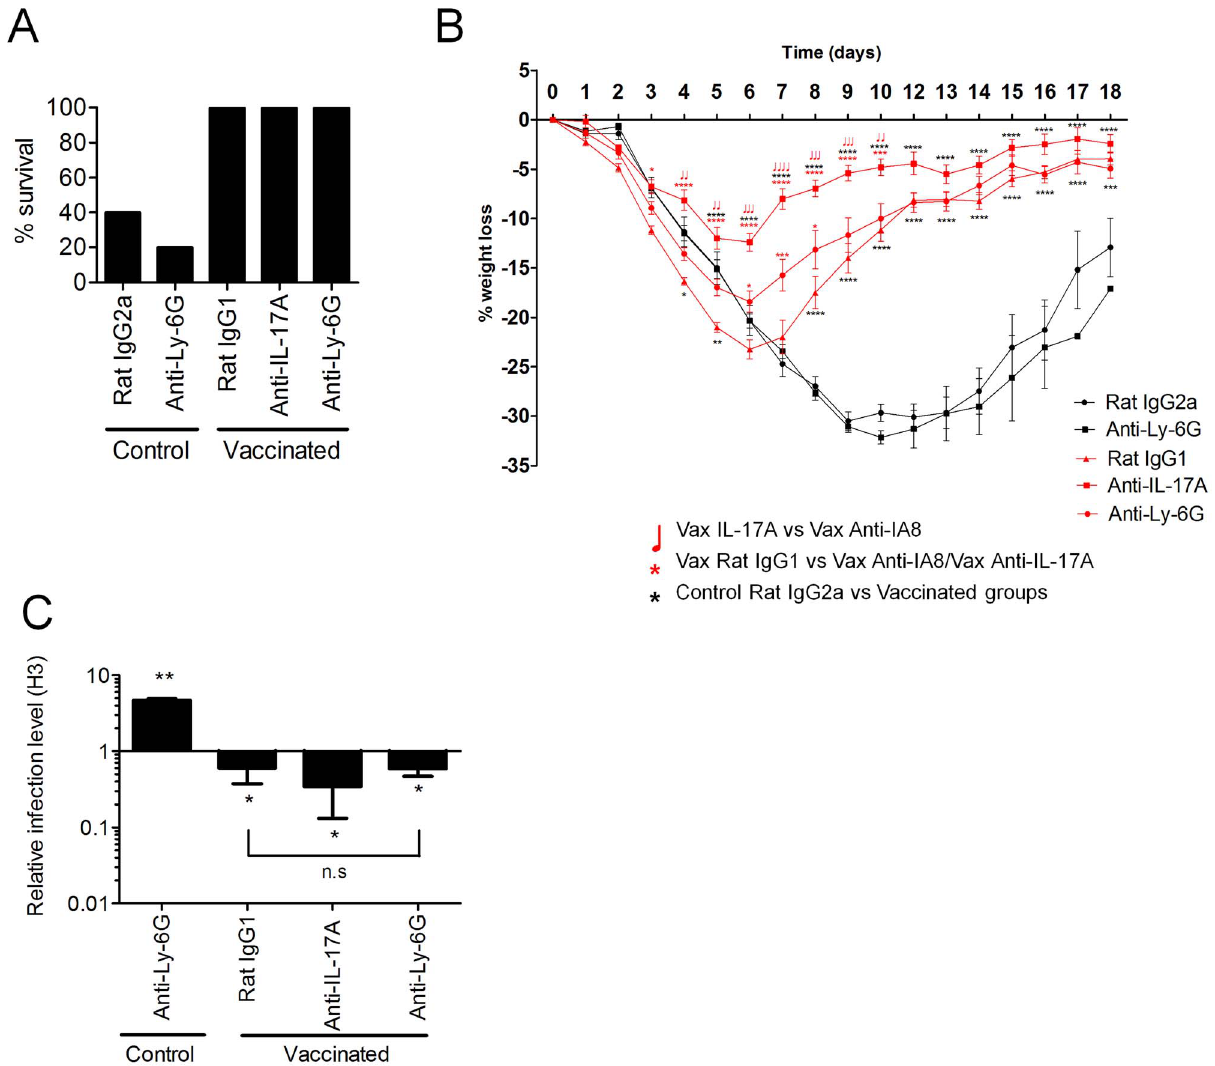
Figure 7. Neutralization of IL-17A and neutrophil depletion ameliorates enhanced weight loss. Mice vaccinated intranasally with split influenza virus antigen (A/Uruguay/716/2007 (H3N2)) and CRX-601 were administered with anti-Ly-6G (IA8) or anti-IL-17A (100 m g) i.p. one day prior to 5LD 50 challenge with influenza A/Hong Kong/1968 (H3N2) and then daily for a further 6 days post challenge. Control mice were vaccinated with split flu plus vehicle and treated with anti-Ly-6G or isotype control antibodies as indicated. Survival (A) and percentage weight loss (B) were examined following influenza virus challenge (10 mice/group). Black lines indicate weight loss in control (split-flu + vehicle) mice and red lines indicate weight loss in adjuvanted groups treated with the indicated antibody. At day 5 post influenza challenge, (C) viral titers in the lung relative to control mice were evaluated (Rat IgG2a) by RT-PCR. This data is representative of two independent experiments. * p , 0.05, ** p , 0.01, *** p , 0.001, **** p , 0.0001 are significantly different from control, Rat IgG2a unless otherwise stated (One-way ANOVA, Dunnet